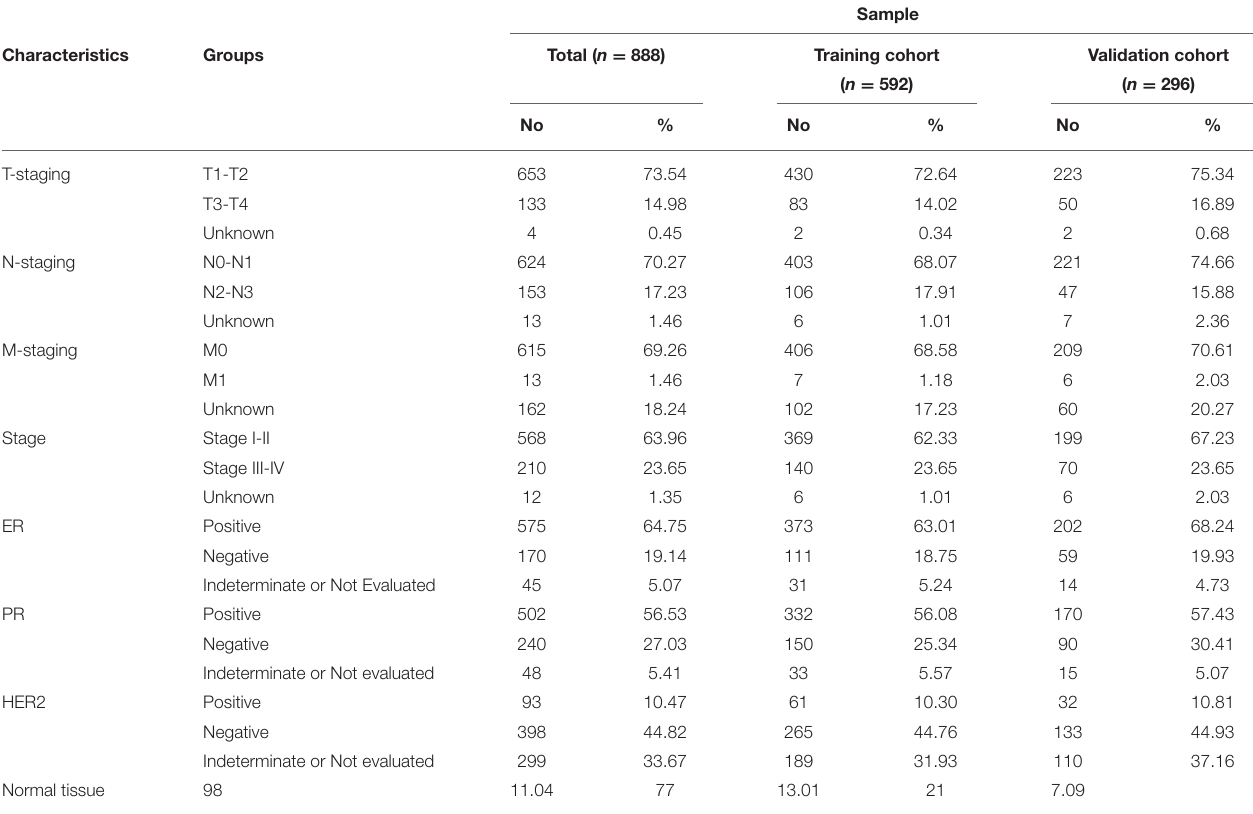
TABLE 1 | Clinicopathological characteristics of BRCA sample.